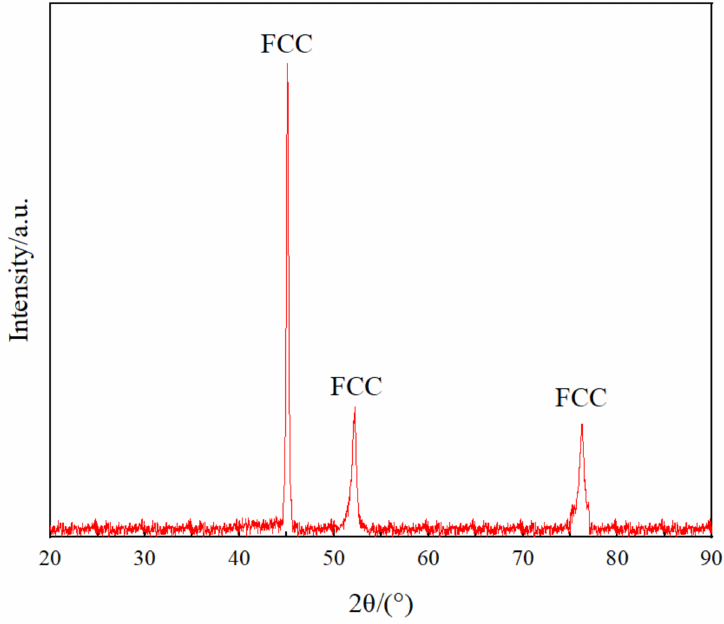
Figure 2. X-ray diffraction (XRD) results of Co 32 Cr 28 Ni 32 . 94 Al 4 . 06 Ti 3